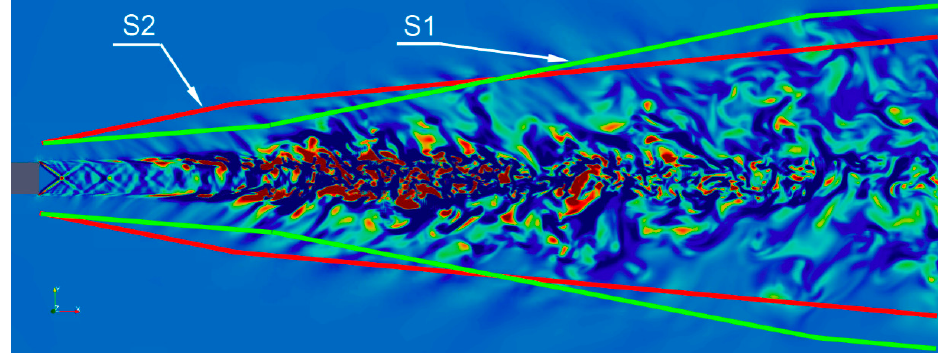
Figure 9. ( a ) Droplet size distribution at the injection and for the end of simulation; ( b ) droplet size along the x-direction.